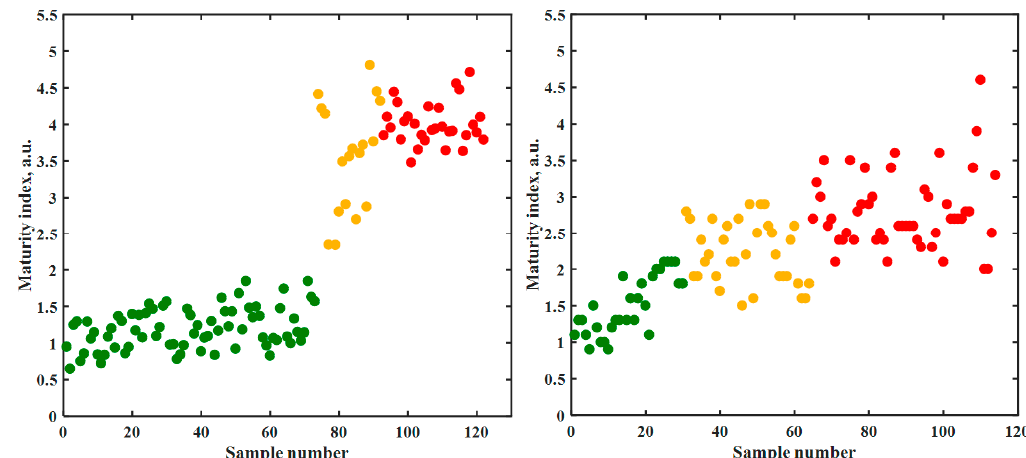
Figure 6. Maturity index for each fruit sample calculated according to equation 1 for hot peppers ( left ) and tomatoes ( right ) at different maturity stages. Color coding corresponds to visually perceived green (green), orange to orange/red (orange) and red fruit (red), cf. Table 3.